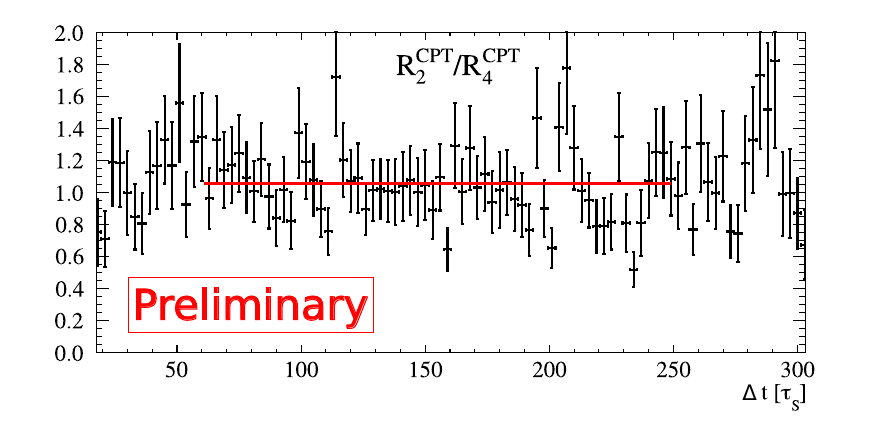
Figure 1. Preliminary distribution of the CPT violation-sensitive double ratio of neutral kaon double decay rates as a function of the time di ff erence between entangled kaon decay times ( ∆ t ). The statistical uncertainty of the asymptotic level of this observable for ∆ t (cid:29) τ S (red line) amounts to 0.011 using the full KLOE